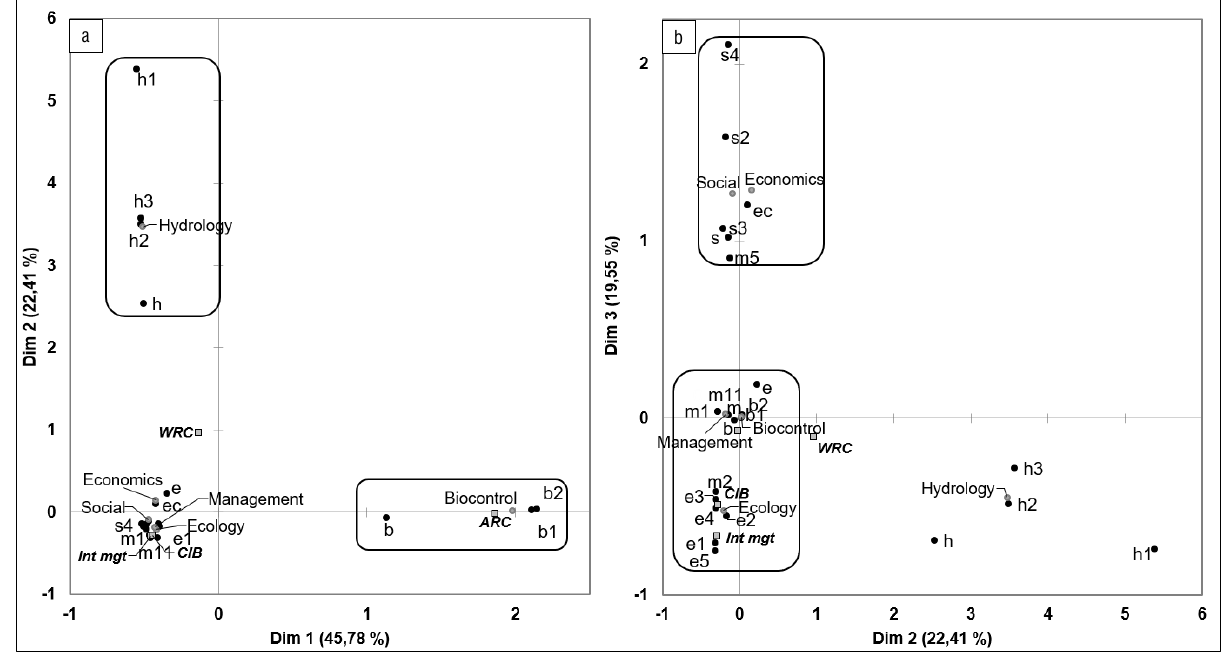
Figure 3: Correspondence analysis showing the relationship between research areas and priorities based on categories listed in Table 3. The two- dimensional solution (3a) explains 68.19% of the correspondence between research areas and priorities. The second solution (3b), Dim 2 and Dim 3, explains 41.95% of the